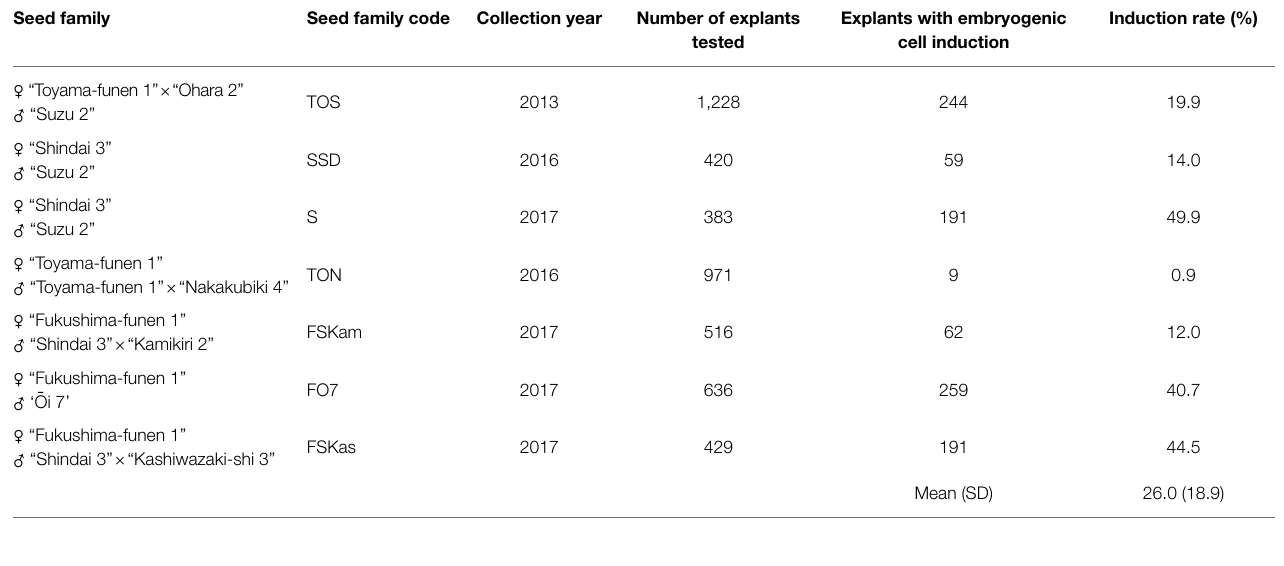
TABLE 4 | Embryogenic cell induction from different pollen-free sugi ( C. japonica ) seed families.